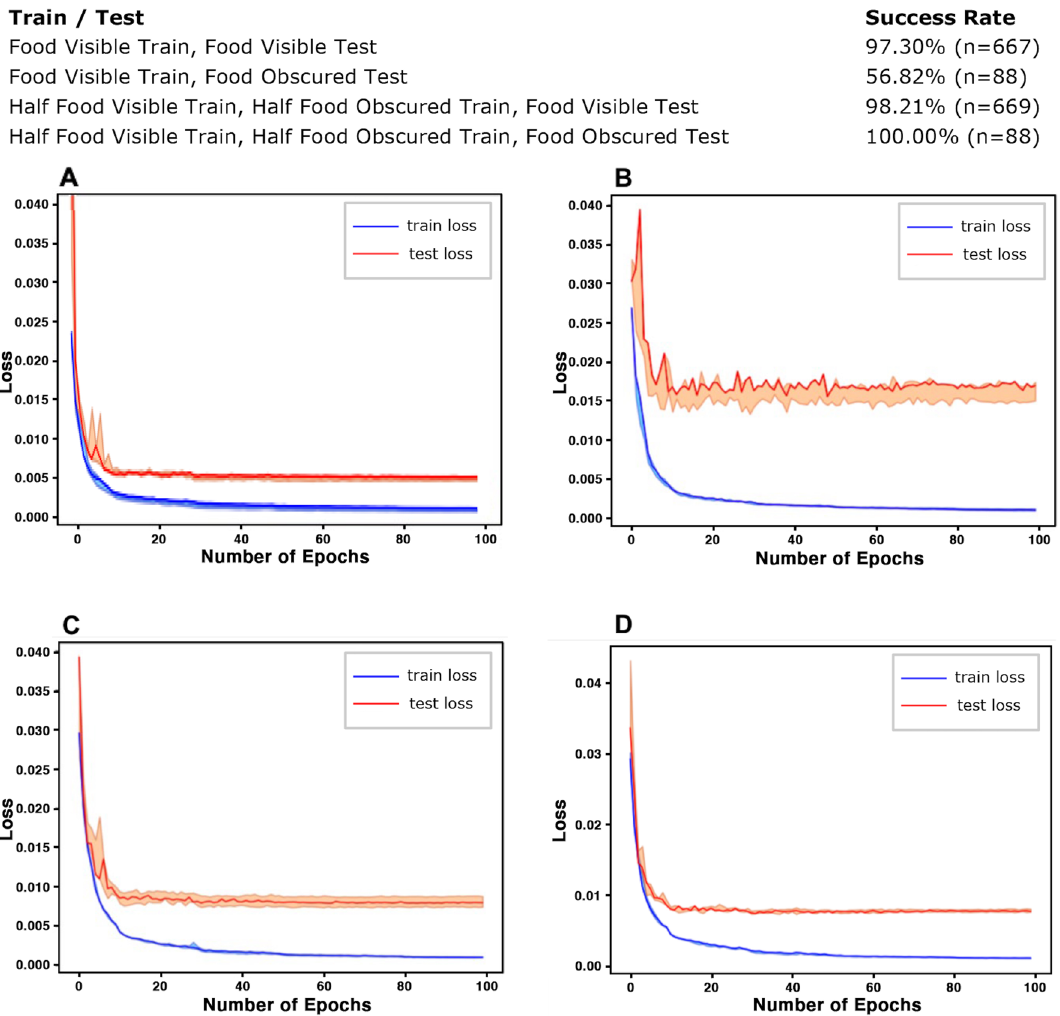
Figure 7. Training and testing of the observer and corresponding success rate We first gathered training and testing data by randomly placing the actor, two green food items, and the obstacle (Table, A ). We also collected “obscured” test cases where we deliberately placed the closest food to where it is not visible to the actor (Table, B ). Higher success rates were achieved by balancing the training data with half “visible” data and half “obscured” data (Table, C and D ). Learning curves across all four above scenarios are shown. Error bars are presented to show experiment results across three different random seeds used in both data splitting and network